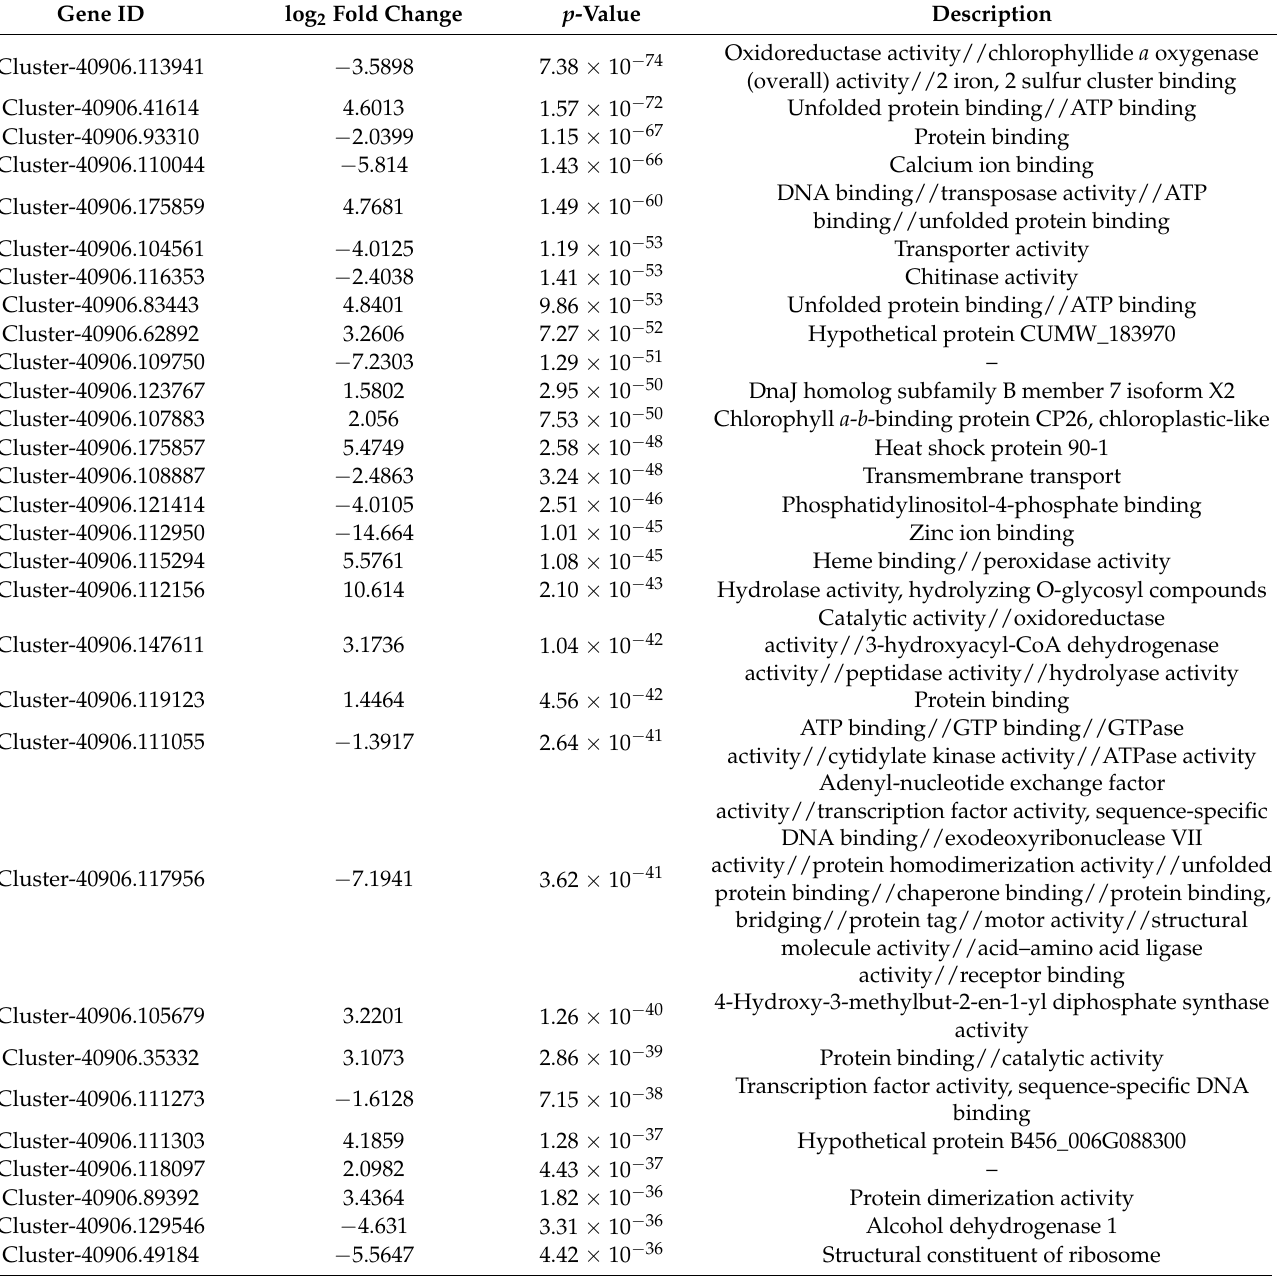
Table 3. Top 30 genes showing significant differential expression under drought